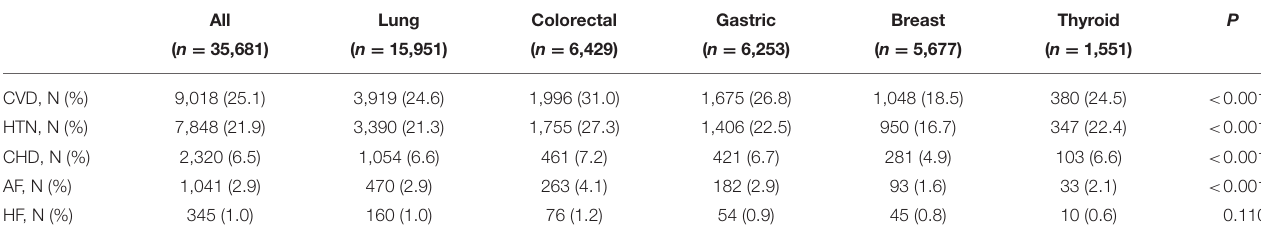
TABLE 2 | Prevalence of cancer patients with CVDs.